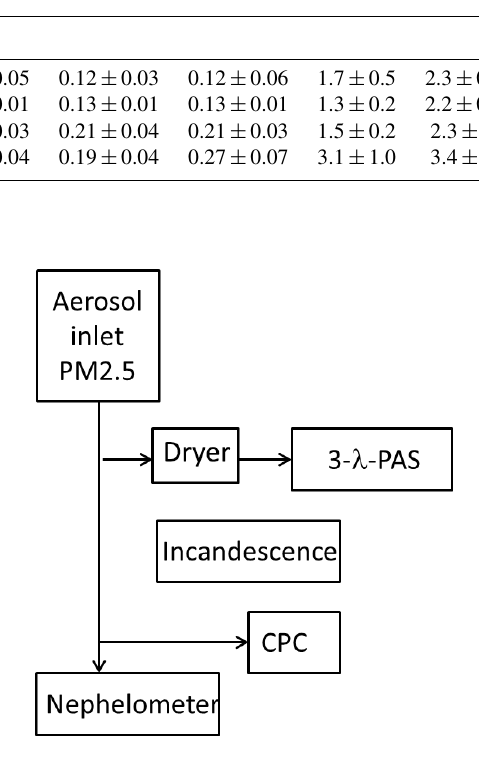
Table 2. Optical properties resulting from different C / O ratios of miniCAST soot during SOOT15. C / O